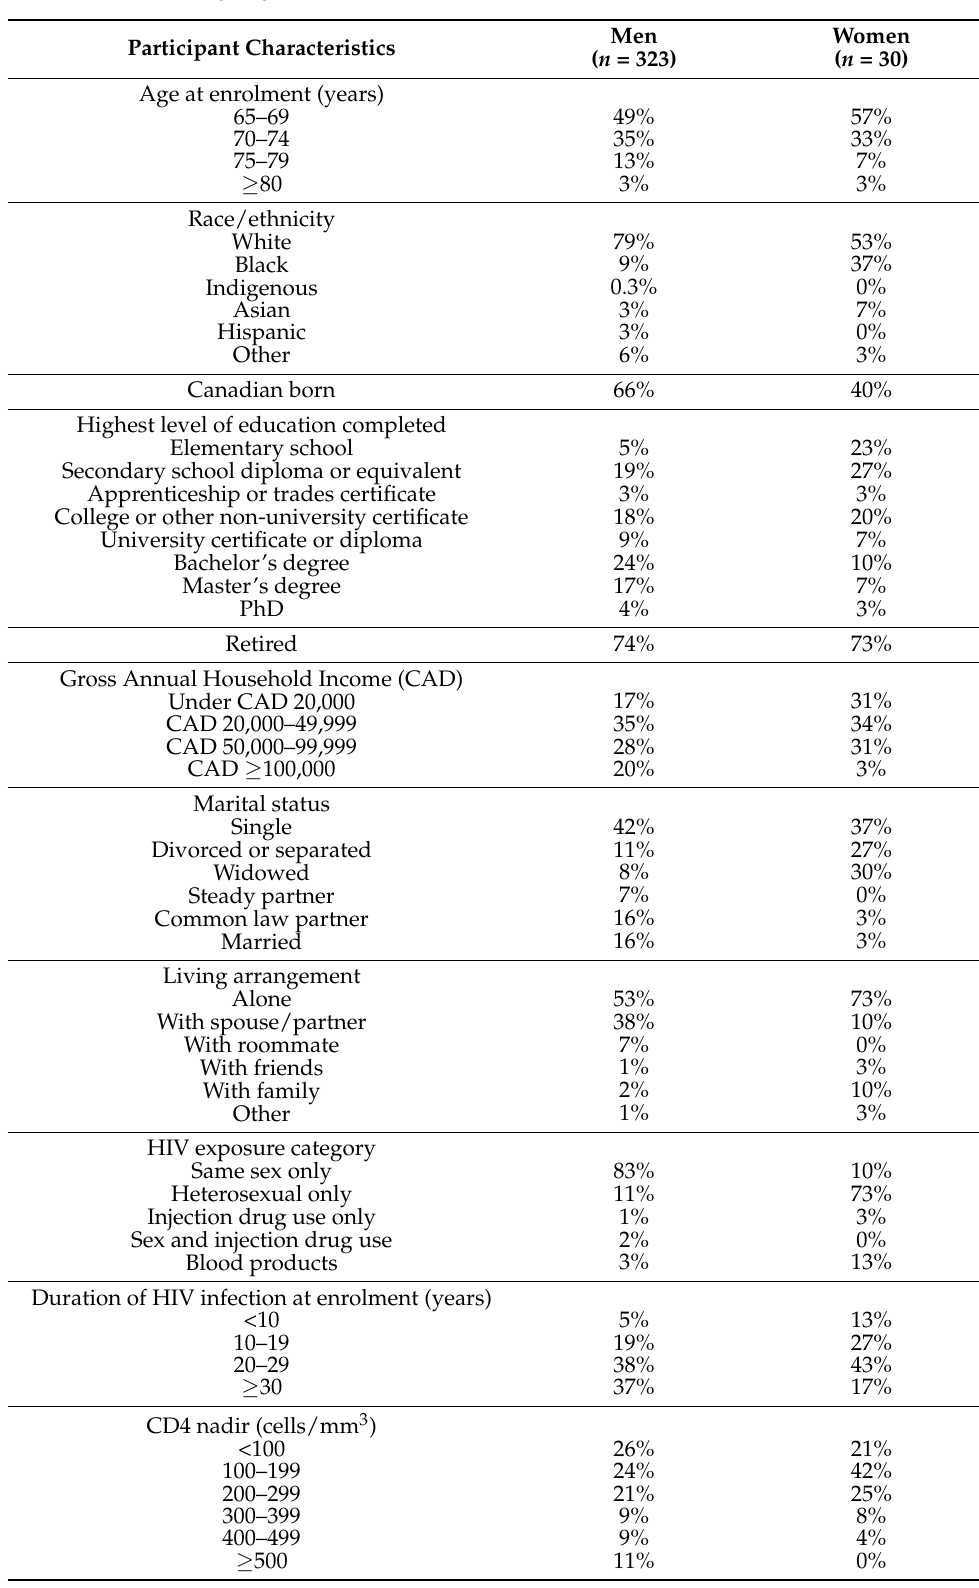
Table 1. Sociodemographic and baseline HIV characteristics of participants enrolled in the CHANGE HIV cohort, according to